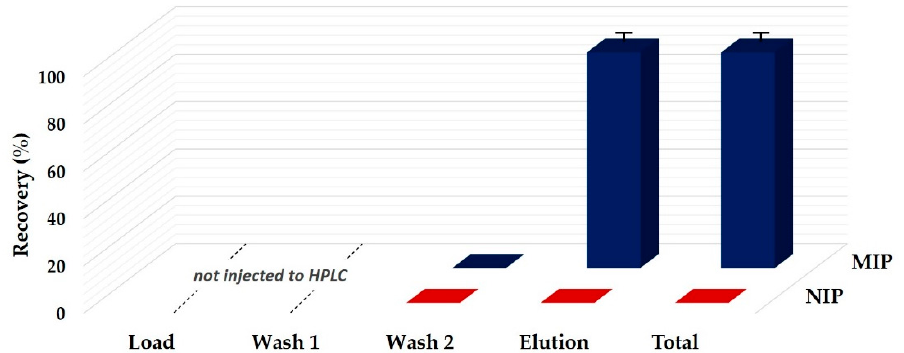
Figure 3. Recovery profile of zearalenone (ZON) obtained on NIP and MIP using a maize oil sample spiked with ZON at a level of 150 µ g / kg. Load: 3 mL of maize oil / diethyl ether (1:3 v / v ); Wash 1: 6 mL of diethyl ether; Wash 2: 6 mL of water / acetic acid / acetonitrile (58:2:40 v / v / v ); Elution: 4 mL of methanol / acetic acid (98:2 v / v ).